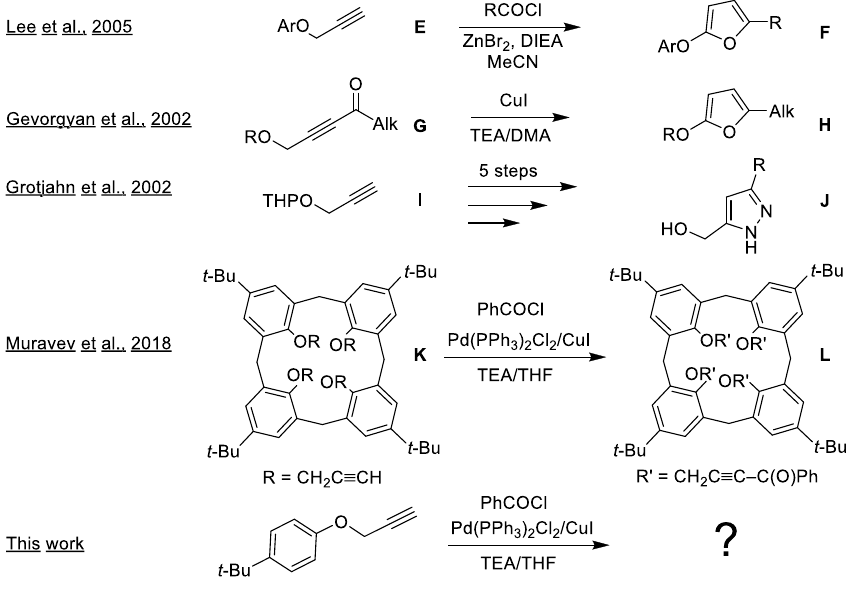
Scheme 1. Synthetic routes towards furans [18,19] and pyrazoles [21,22] from heteropropargyl